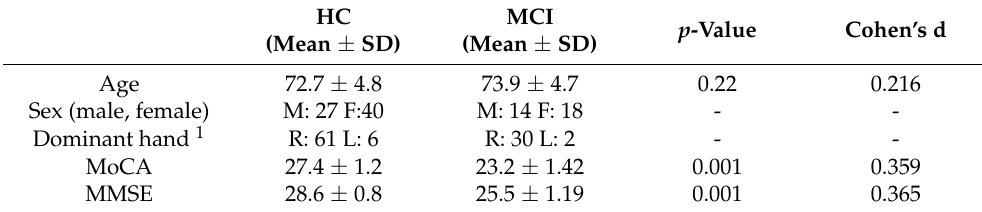
Table 1. Demographic characteristics of the participants.